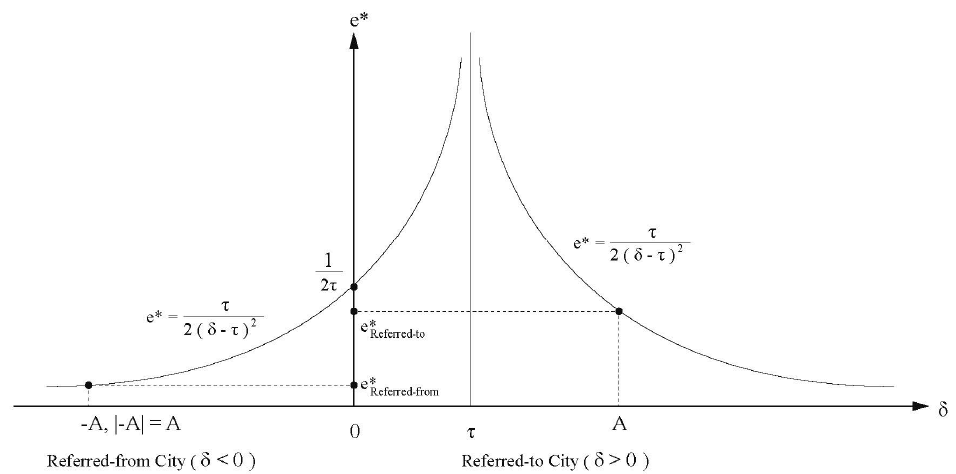
Figure 4. Algebraic relationship between δ (the differences of medical service quality between the referred-in city and the referred-from city) and e ∗ (their optimal effort levels).